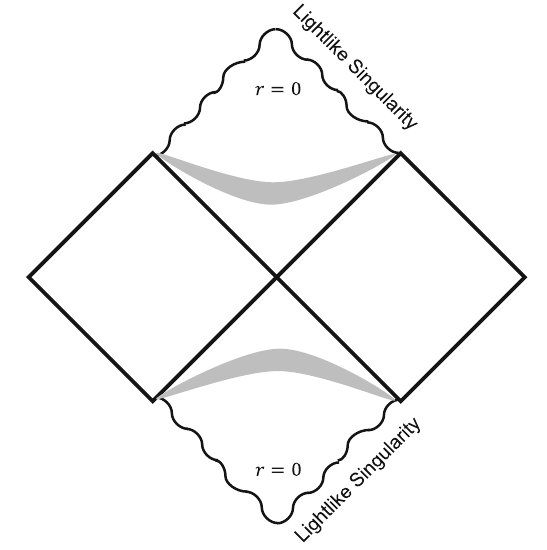
Fig. 5 The Penrose diagram of the lightlike singularity in the black hole for δ > 0. The curly lines indicate the lightlike singularities. The shadowedregionsrefertothespacetimepatchesaround x i ,ifwematcha Schwarzschildspacetimeandtheinteriorspacetimewithnon-vanishing mimetic